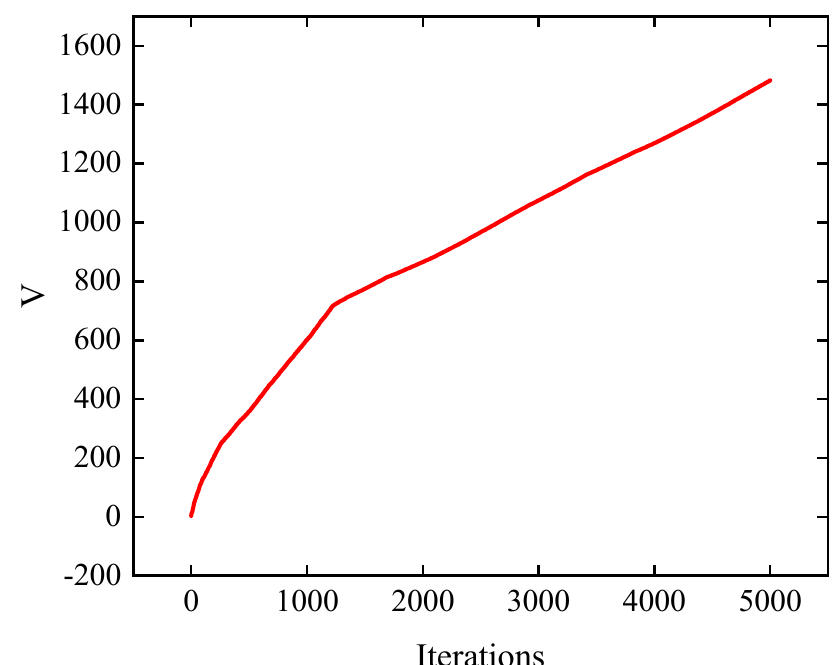
Figure 14. Impulse emission rate.